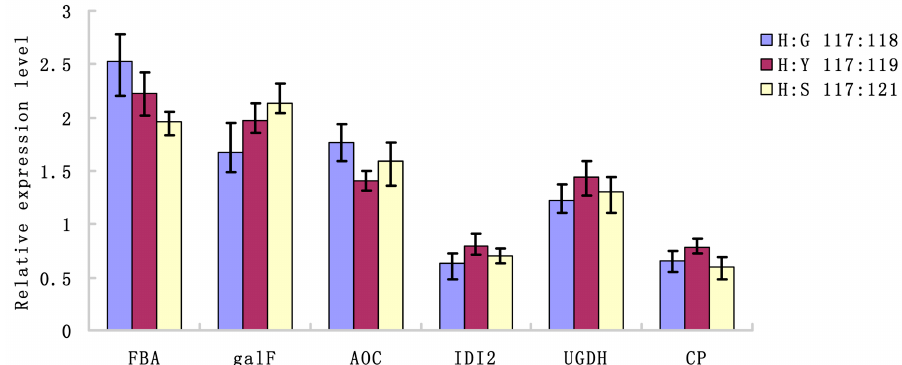
Figure 6. Relative expression abundance analysis of differential proteins at the transcriptional level by RT-qPCR. The 18sRNA gene was used as the internal control. To determine the relative fold differences for each gene, the Ct value of the genes was normalized to the Ct value for the 18sRNA (control gene), and the relative expression was calculated relative to a calibrator using the formula 2 − ∆∆ C t . All the values shown are means ± SE.